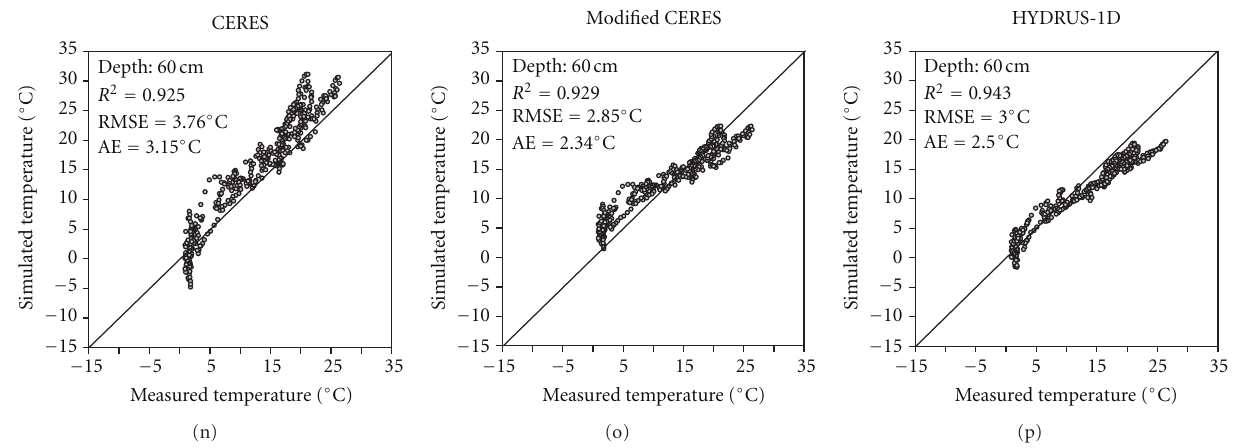
Figure 4: Comparison of the measured and calculated soil temperature values at di ff erent depths, at ˝Orbotty´an, Hungary.